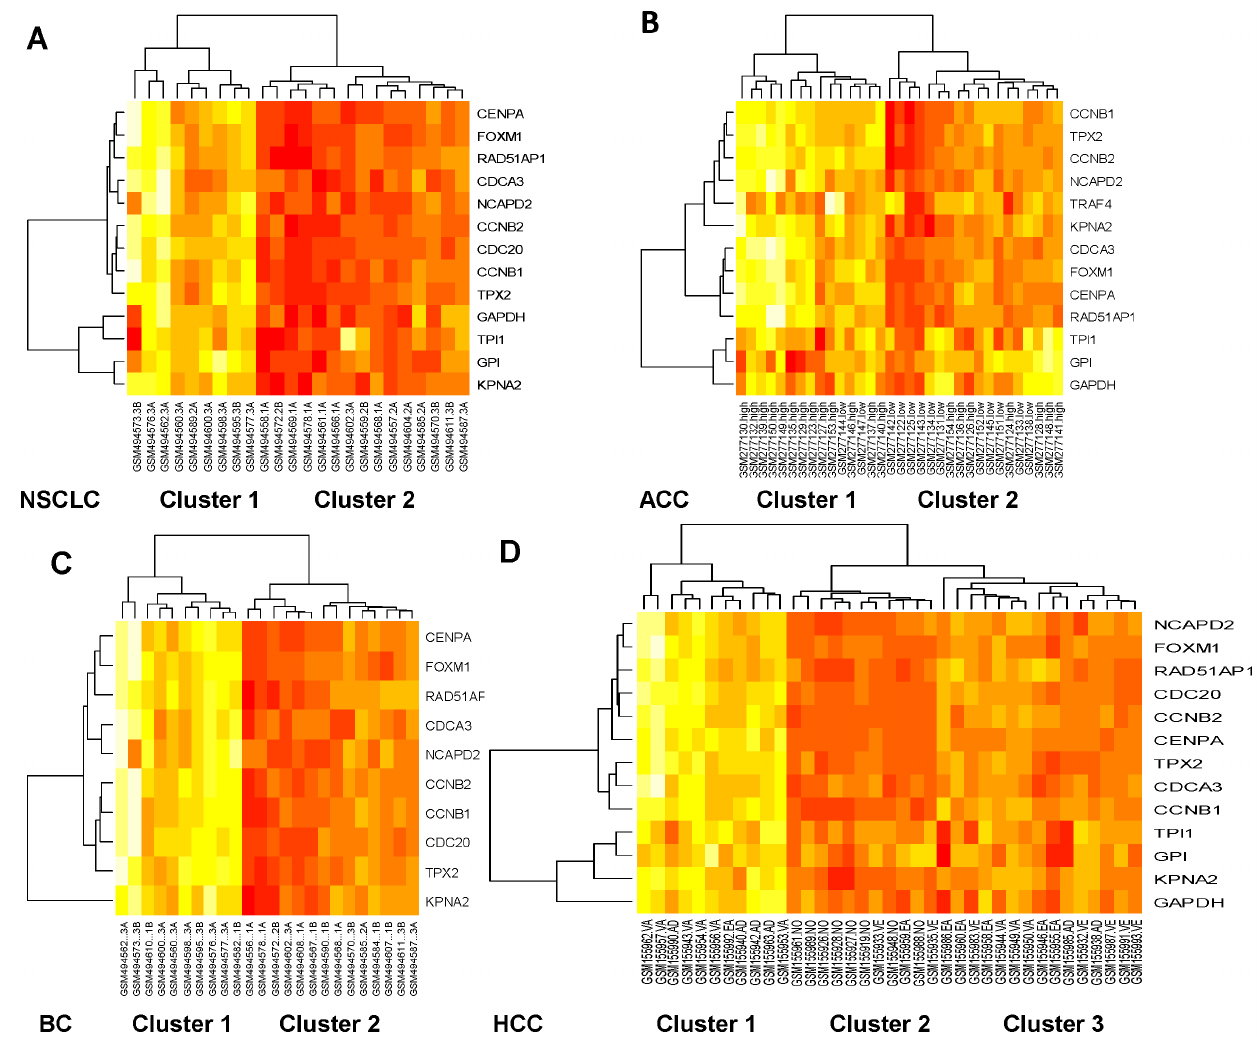
Figure 5. Hierarchical clustering of GAPDH associated genes from various cancer cohorts. The rows of a microarray heat map represent genes with each column of that row representing a different sample (source name followed by disease status). The gene expression values from four cohorts of NSCLCs with different tumor stages (I, II, III) (A), adrenocortical carcinomas (ACC) with tumor grades (high or low) (B), breast cancers (BC) with different tumor grades (I, II, III) (C), and Hepatocellular carcinomas (HCC) with different tumor stages (very early, early, advanced, very advanced) and normal liver (D) are clustered and presented by heat map.